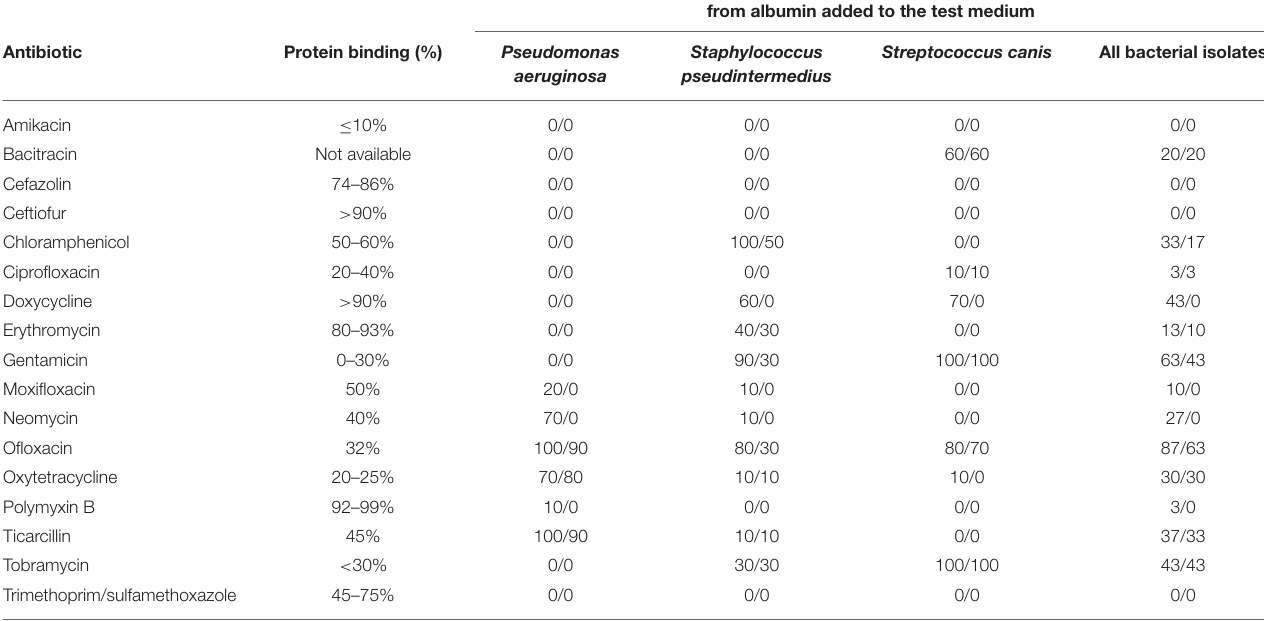
TABLE 2 | Frequency of bacterial isolates with (increased MIC)/(changes in clinical interpretation) when comparing standard test medium (Mueller Hinton broth, no albumin) vs. Mueller Hinton broth supplemented with clinically relevant levels of canine albumin. Percent bacterial isolates with increased MIC/changes in clinical